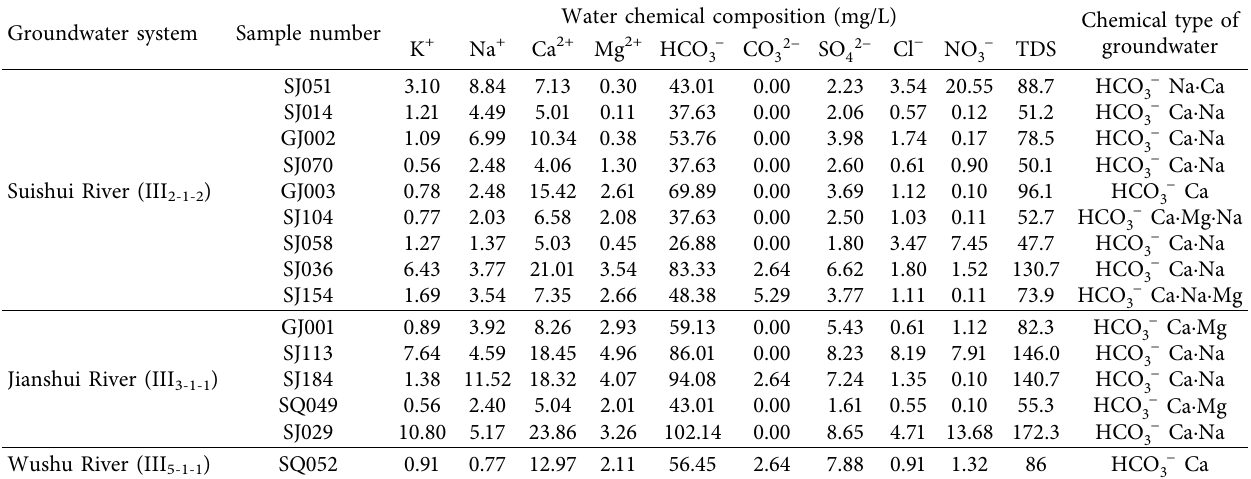
Table 3: Chemical composition of various groundwater systems in the study